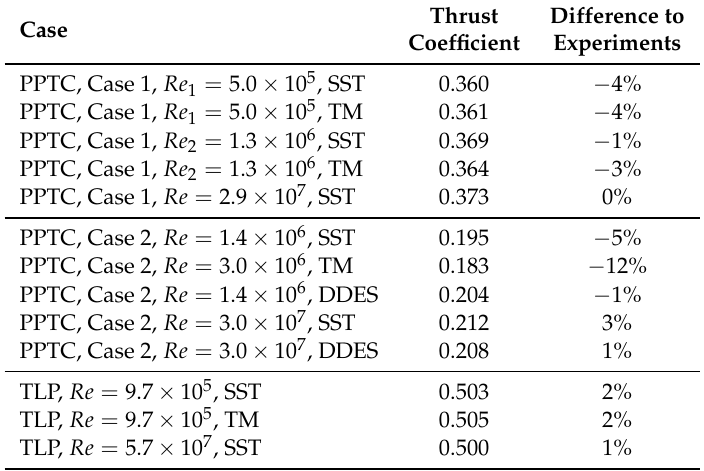
Table 4. Predicted thrust coefficients in cavitating